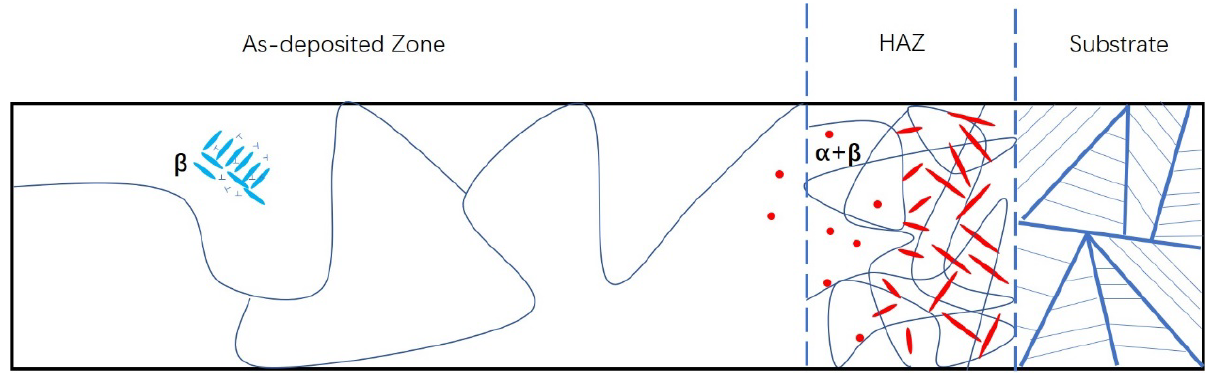
Figure 13. Schematic diagram showing the microstructure evolution in the LMD+LSPned sample. The greatest difference between as-LMD and LMD+LSPned samples is the in-depth residual stress field. There are micropores or voids in the sub-surfaces of both samples. These flaws are the result of gas entraining and rapid cooling rate brought by turbulence in the molten pool, which eventually results in stress concentration and the increase in the rate of crack growth under the fatigue load [11]. LSP transformed the residual stress in the surface of the as-LMD sample from the tensile to the compressive state. By contrast, during the crack growth process, compressive residual stresses reduce the effective applied stress and stress intensity factor range at the crack tip, simultaneously causing a crack closure effect, which decreases the crack propagation rate and consequently increases the cyclic life of the LMD+LSPned sample